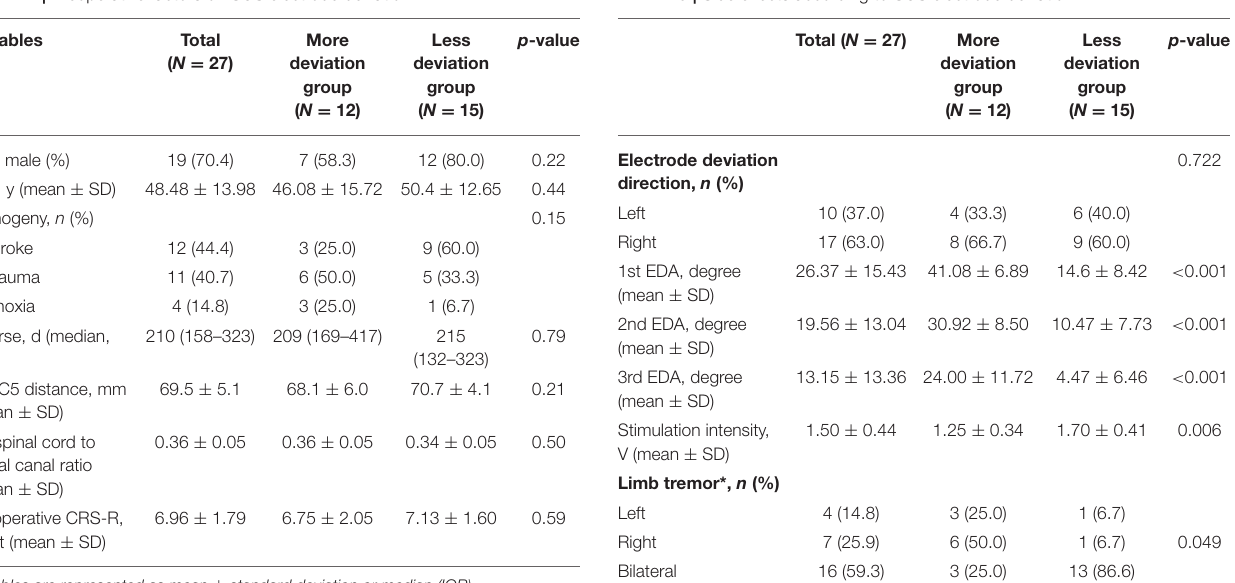
TABLE 3 | Side effects according to SCS electrode